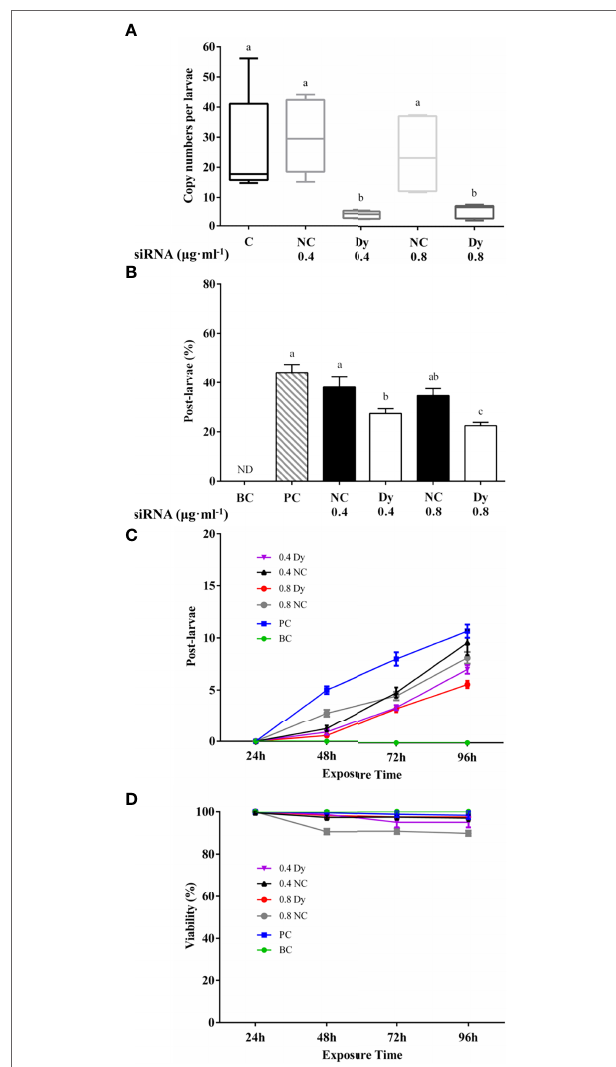
FIGURE 4 | Effect of electroporation on McDy expression (A) , metamorphosis (B) , the cumulative number of post-larvae (C) and viability (D) of the hard-shelled mussel larvae. (A) Quantitative RT-PCR expression of the McDy in electroporated and control larvae. Significant differences ( p < 0.05) are represented by different letters above the columns. C: control; NC: negative control (electroporated with the non-sense siRNA, 0.4 and 0.8 μg ml -1 ); Dy : electroporated with the McDy siRNA (0.4 and 0.8 μg ml -1 ). (B) Percentage of larvae metamorphosed at 96 h. The results are represented as mean ± SEM of nine experiments containing 20 larvae per replicate. Different letters above the bars indicate statistically significant differences ( p < 0.05). BC: blank control; PC: positive control; NC: negative control (electroporated with the non-sense siRNA, 0.4 and 0.8 μg ml-1); Dx: electroporated with the McDy siRNA (0.4 and 0.8 μg ml-1). (C) The cumulative number of post-larvae at each time point of the metamorphosis assay (EPI induction) in control and McDy siRNA, non-sense siRNA electroporated pediveliger larvae. The results are presented as the mean ± SEM of nine experimental replicates (each containing 20 individuals). (D) Viability of mussel larvae in the metamorphosis assay (EPI induction) after electroporation with McDy siRNA or non-sense